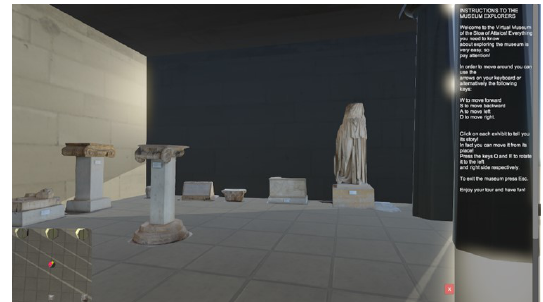
Figure 6: The environment of the virtual museum